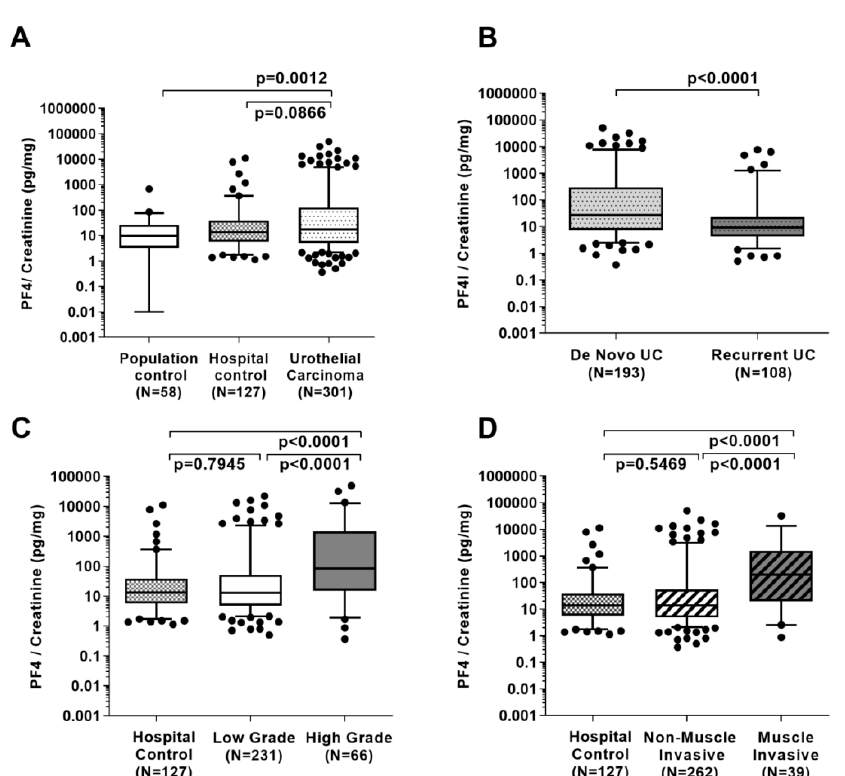
Figure 2. Creatinine-normalized PF4 concentration in urine of UC patients, and hospital and population controls ( A ), in de novo UC patients and those with UC history ( B ), in hospital controls compared to high and low-grade UC ( C ) and compared to non-muscle invasive ( ≤ pT1) and muscle invasive UC patients (>pT1) ( D ). Group differences were calculated by Wilcoxon rank-sum tests (non-parametric).